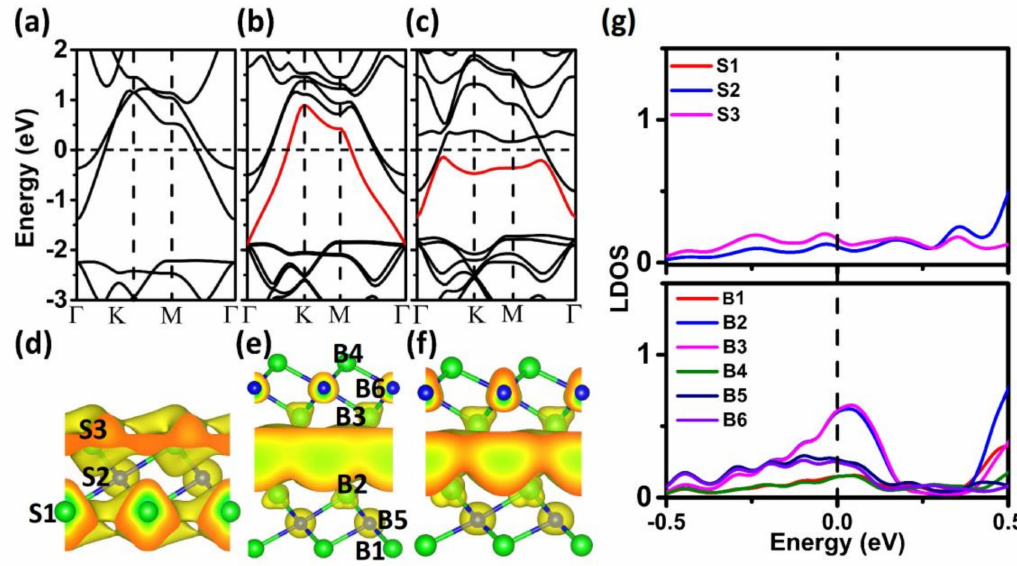
Figure 6. Band structures of ( a ) monolayer Ca 2 N and ( b , c ) bilayer Ca 2 N under the loads of 0 and 3 nN, respectively. Fermi energy is set at zero. ( d ) Partial electron density isosurface (with the threshold value of 0.002/Å 3 ) for all states within the energy range |E − Ef|< 0.05 eV of (a); ( e , f ) for the red bands of (b) and (c), respectively. ( g ) Local density of states LDOS for monolayer (top panel) and bilayer (bottom panel) Ca 2 N. The corresponding atoms are labeled in (d) and